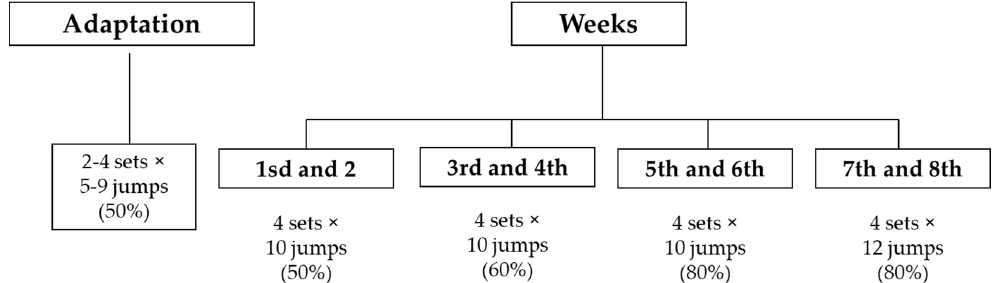
Scheme 1. Strength training program. Adaptation week—three alternate days of exercise sessions with a load of 50% of the animal’s body weight, number of sets and repetitions adjusted for each session (1st day: 2 sets × 5 jumps; 2nd day: 4 sets × 5 jumps; and 3rd day: 4 sets × 9 jumps). 1st and 2nd weeks—4 sets of 10 jumps and an overload of 50% of the animal’s body weight. 3rd and 4th weeks—4 sets of 10 jumps and load of 60% of body weight. 5th and 6th weeks—the 4 sets of 10 jumps and an overload of 80% of the animal’s body weight. 7th and 8th weeks—continue the 4 sets of 12 jumps and load 80% of body weight. A rest period of 30 s was given between all